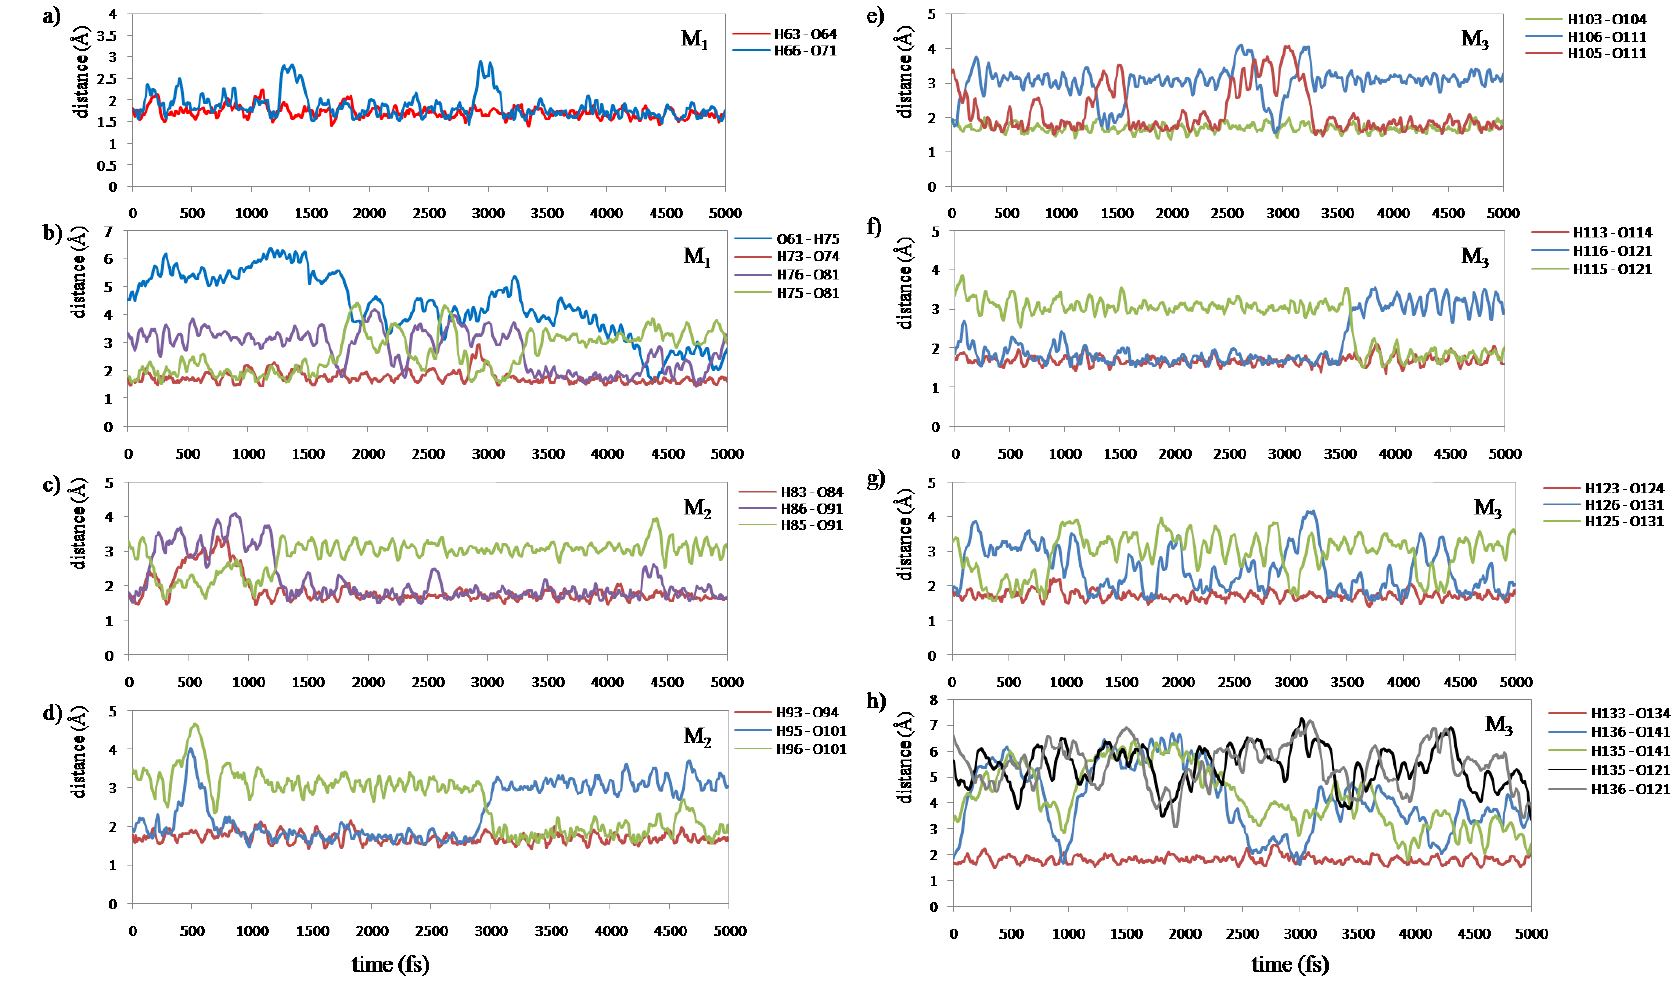
Figure 8. Fluctuations of the H-bond distances between peptide and water molecules in the interacting space (5 ps ELG-MD simulation). The numbering of the atoms is shown in Figure 5. M More details of the H-bond distances in Panel b and h are shown in Figures 9 and 10,